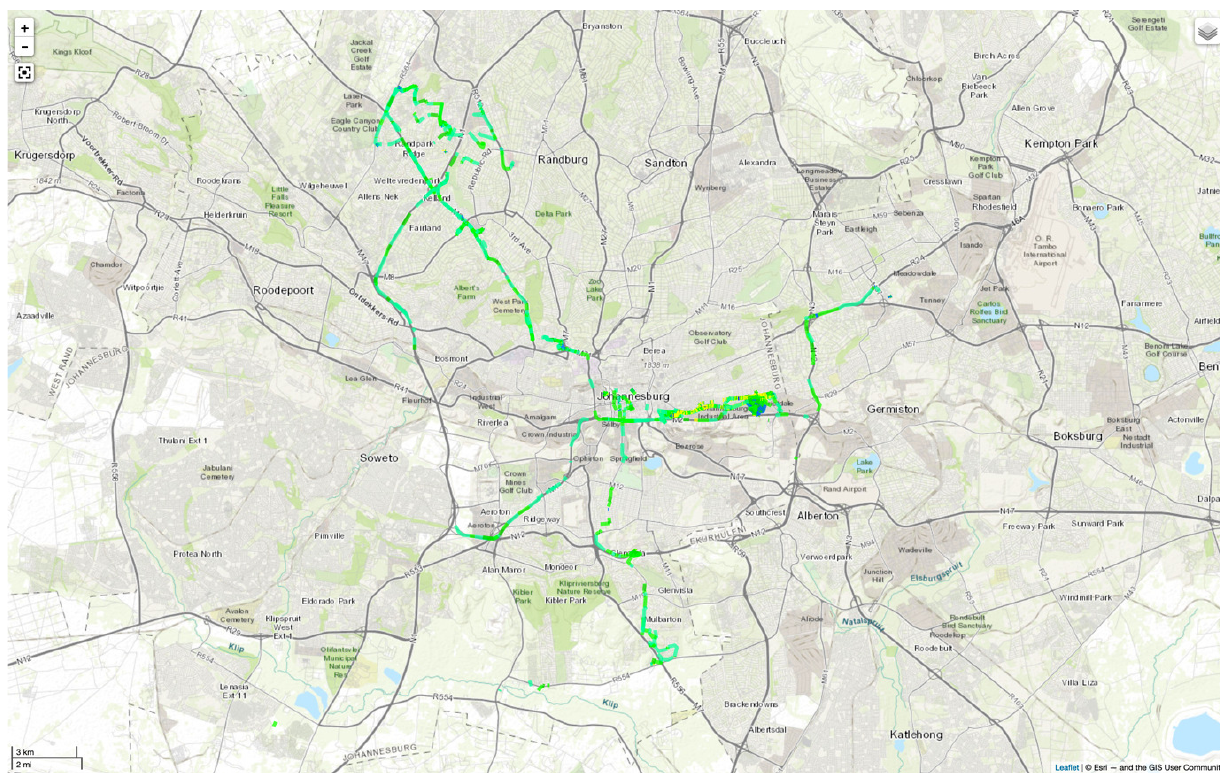
Figure 5. One participant working as a driver shows blue lines for walking around Denver, but otherwise many more green lines indicating vehicular travel throughout the greater Johannesburg area. Source: Map by Chantal Bekkering, 2020.